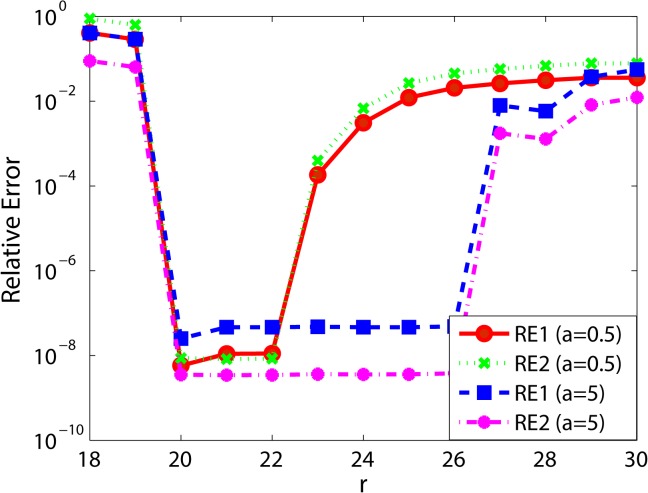
Comparison of relative errors with different r.